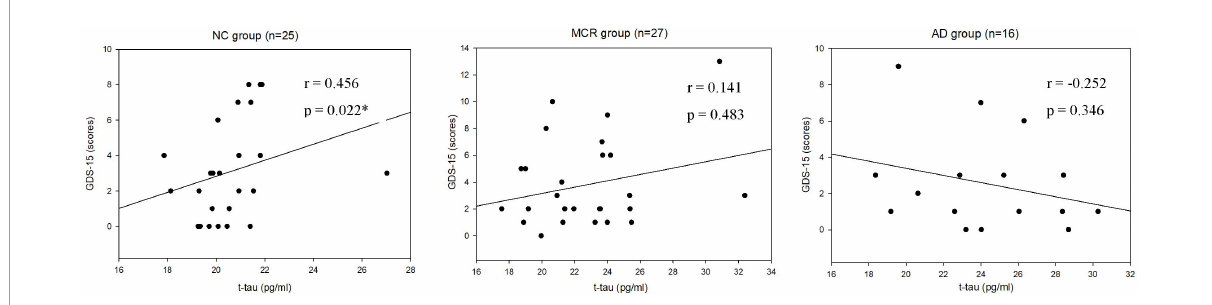
Motoric cognitive risk syndrome ( n = 27)